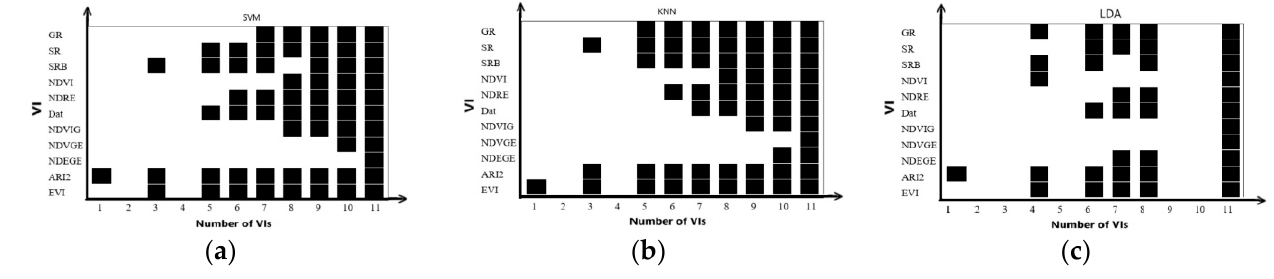
Figure 9. The combinations of worst performance.